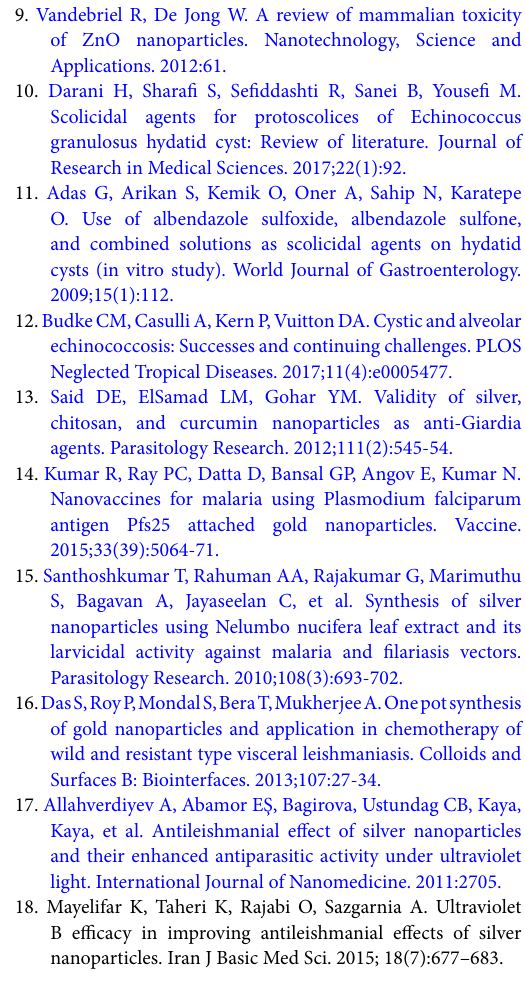
27 Nanomed Res J 4(1): 23-28, Winter 2019